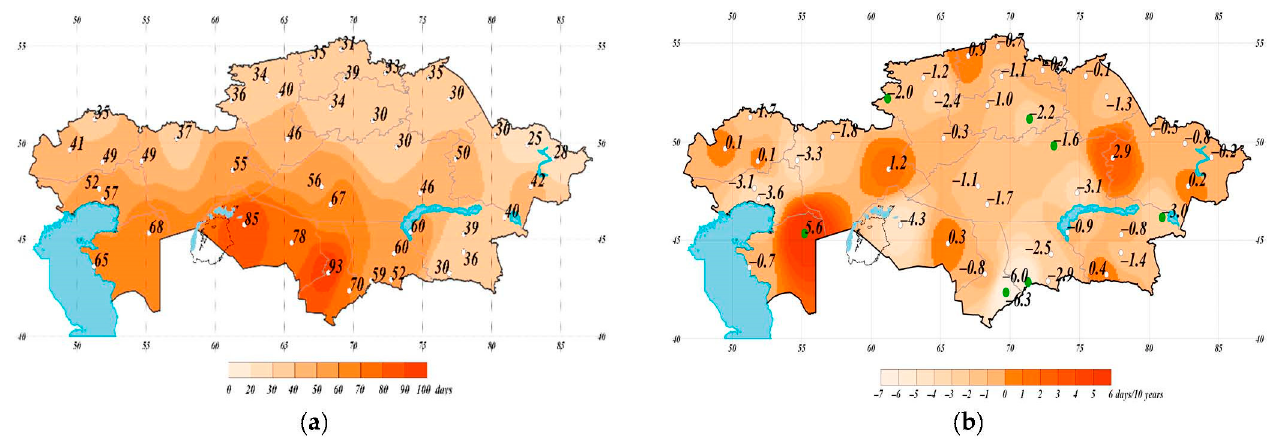
Figure 14. Spatial distribution ( a ) and trend ( b ) of the dry period duration (CDD) index for the period 1971–2020.